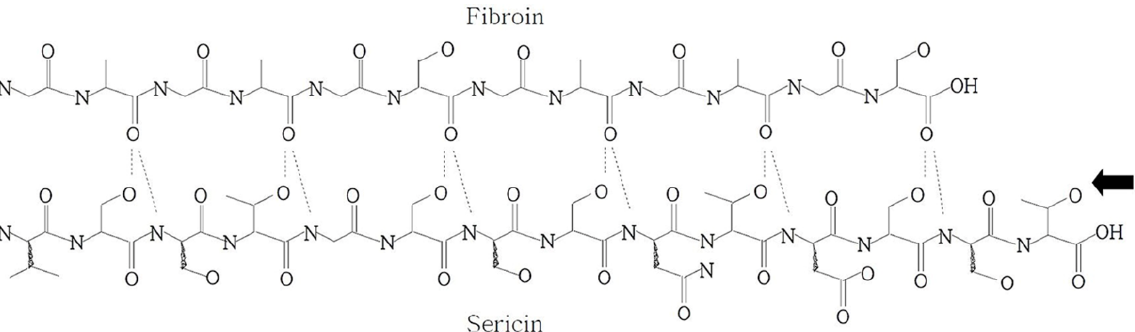
Figure 2. Chemical structure of silk sericin showing the intermolecular hydrogen bonds between the fibroin and sericin. Reprinted with permission from Lee [34]. Copyright © 2022 WILEY-VCH Verlag GmbH & Co. KGaA, Weinheim, Germany.